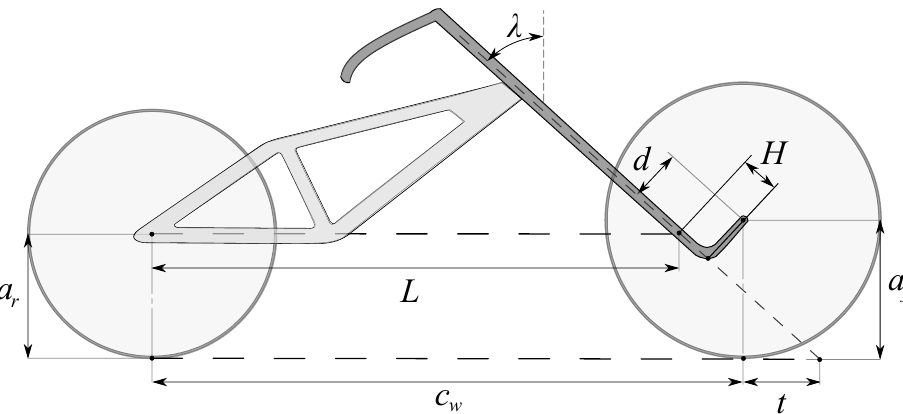
Figure 1. The two-wheeled vehicle system geometric parameters: the wheelbase c w , the trail t , the caster angle λ , the rear and front wheel radii a r and a f , the fork offset d , and the auxiliary parameters L and H